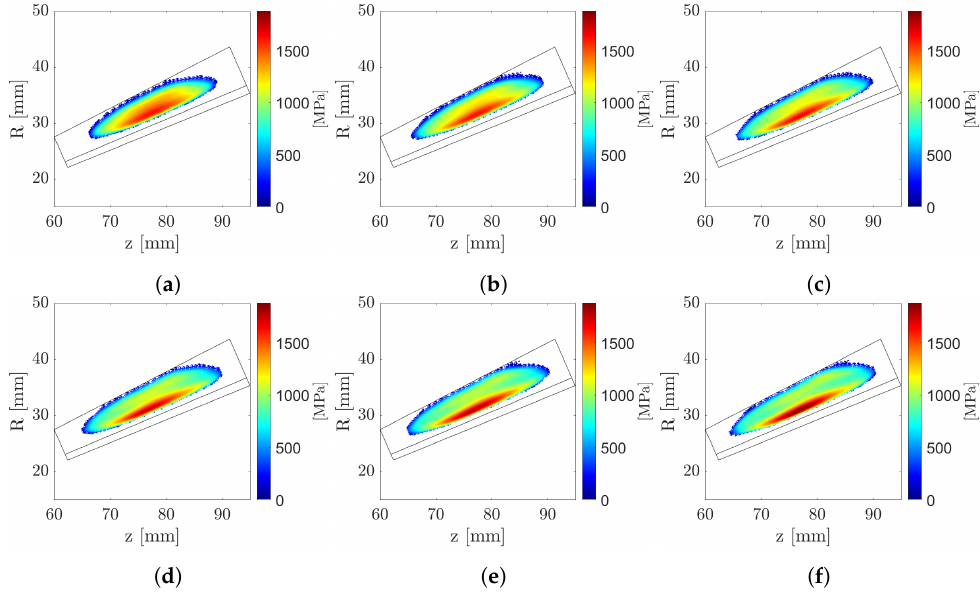
Figure 12. Evolution of the pinion contact pattern with a geometry update every 5 Mc. ( a ) 5 Mc.